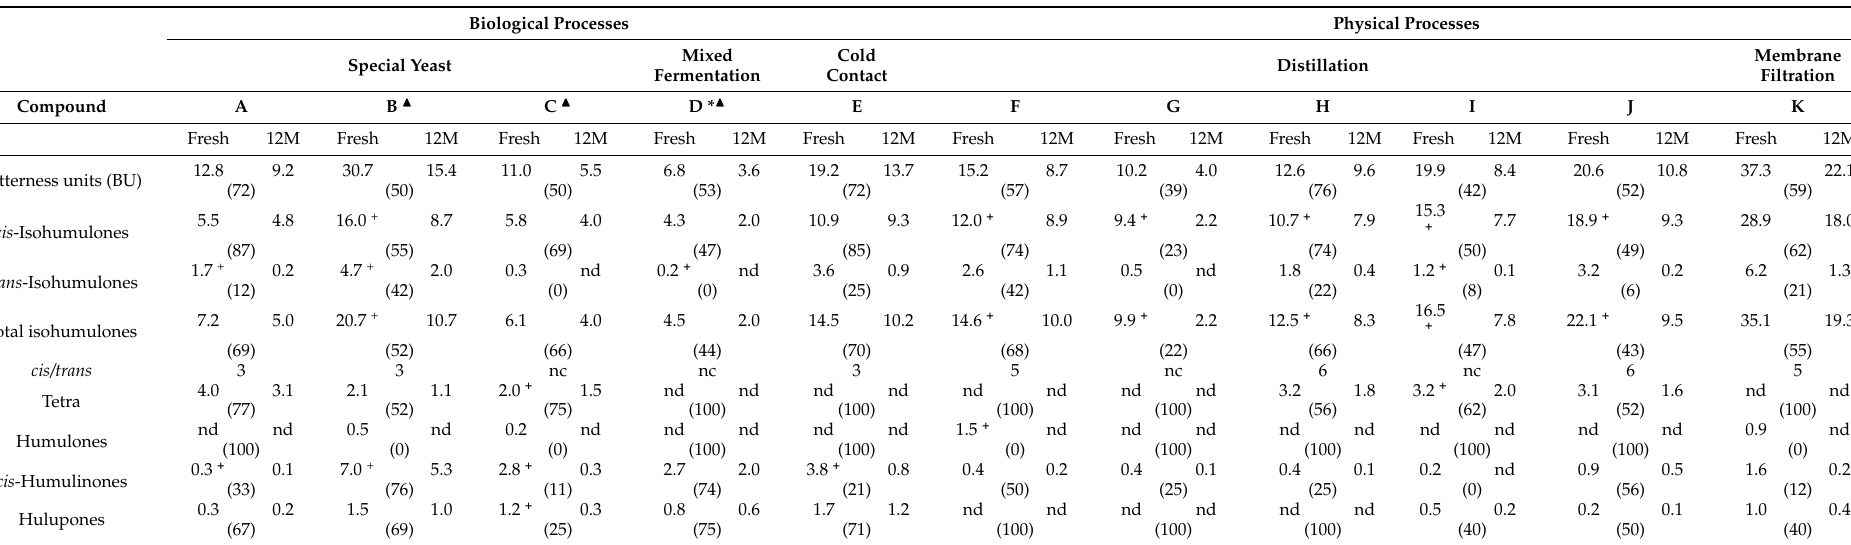
Table 2. Concentrations (mg/L) of isohumulones ( cis and trans ), tetrahydro-isohumulones (tetra), humulones, cis -humulinones, and hulupones in the 11 fresh and aged (12M) investigated NABLABs. Values in parentheses indicate remaining percentages after one year of storage at 20 ◦ C in the